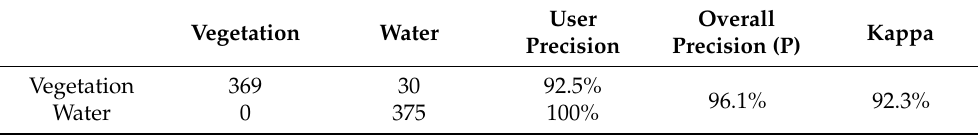
Table 1. Confusion matrix for the accuracy validation of decision trees for extracting algal blooms and aquatic vegetation. The overall accuracy P and kappa coefficients were calculated separately in